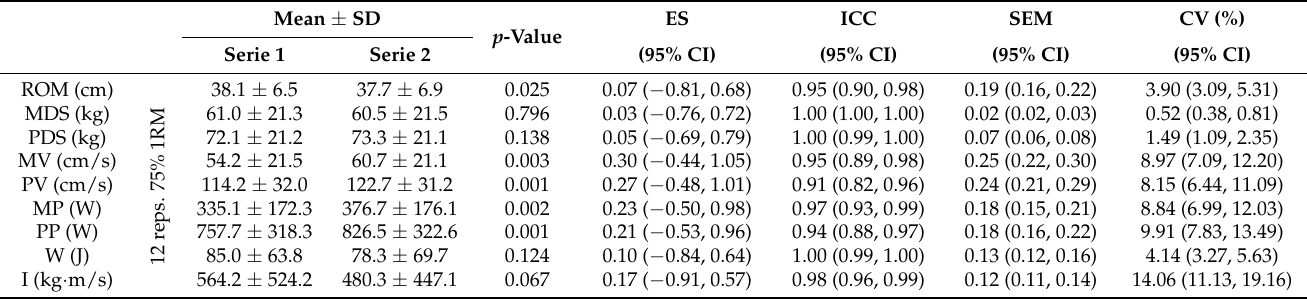
Table 2. Test–retest reliability of all variables during the 75% 1RM protocol using a